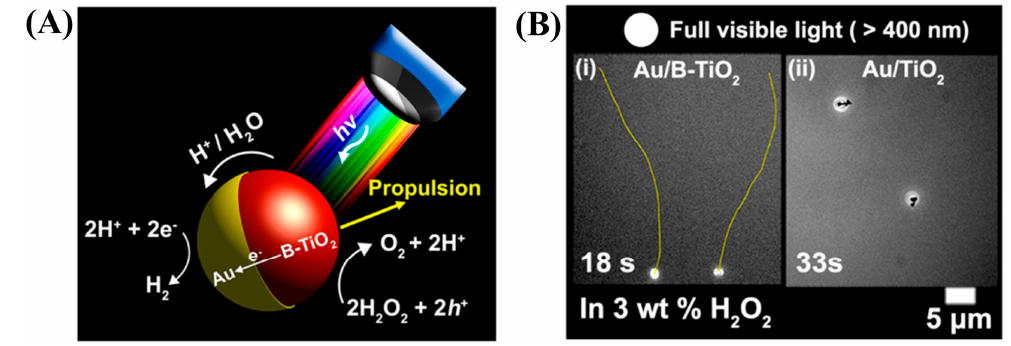
Figure 10. Full visible light (>400 nm) driven Au/B-TiO 2 Janus micromotors. ( A ) Schematic of the propulsion mechanism of Au/B-TiO 2 Janus micromotors; ( B ) Trajectories of (i) Au/B-TiO 2 Janus micromotors over 18 s and (ii) Au/TiO 2 Janus micromotors (control sample) over 33 s. Reproduced with permission [82]. Copyright 2017, American Chemical Society.